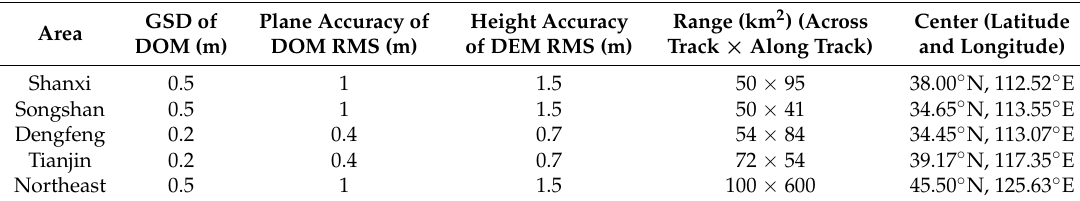
Table 1. Currently available GCFs in